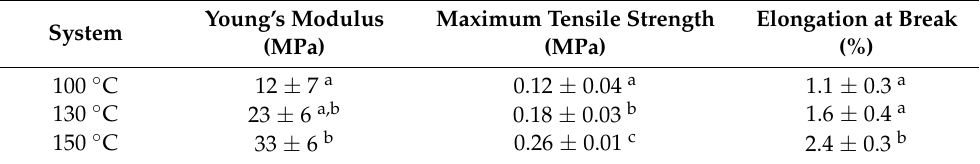
Table 1. Young’s modulus, maximum tensile strength and elongation at break of the different processed systems. Different superscript letters within a column indicate significant differences ( p < 0.05).